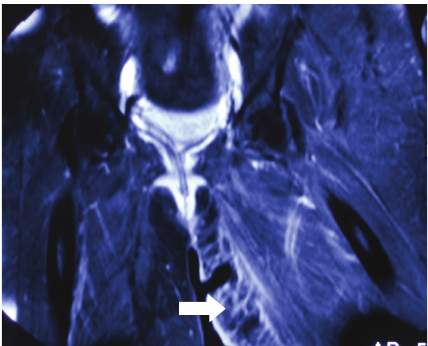
Figure 2: Coronal T1W SPIR images, following Gadolinium admin- istration, show enhancement of the medial part of the left thigh, next to the previously performed surgical wound (white thick